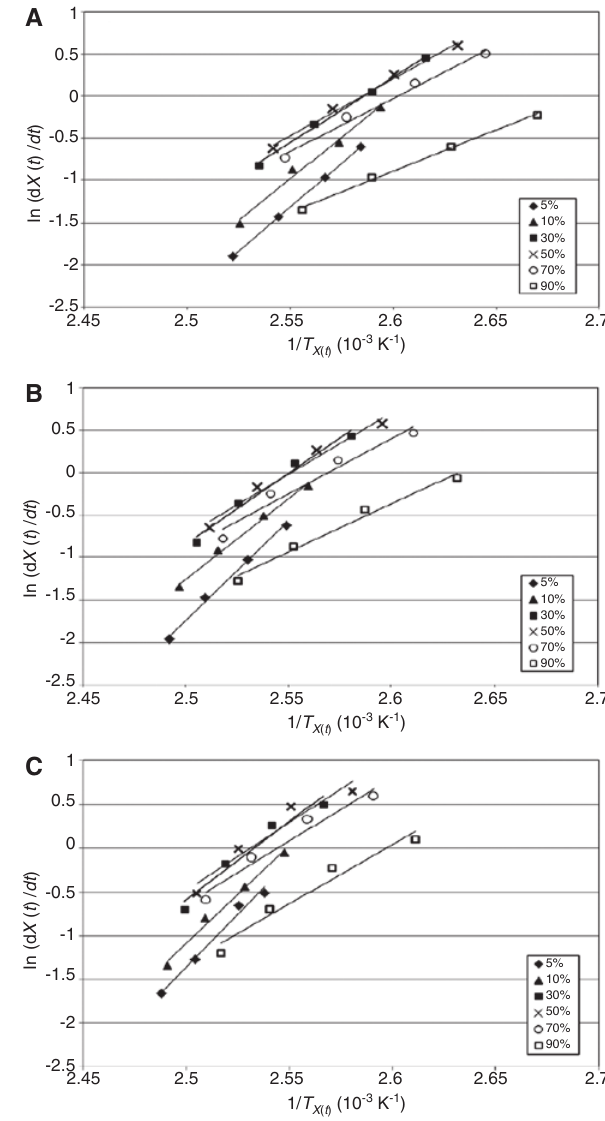
of (A) neat poly- X ( t )